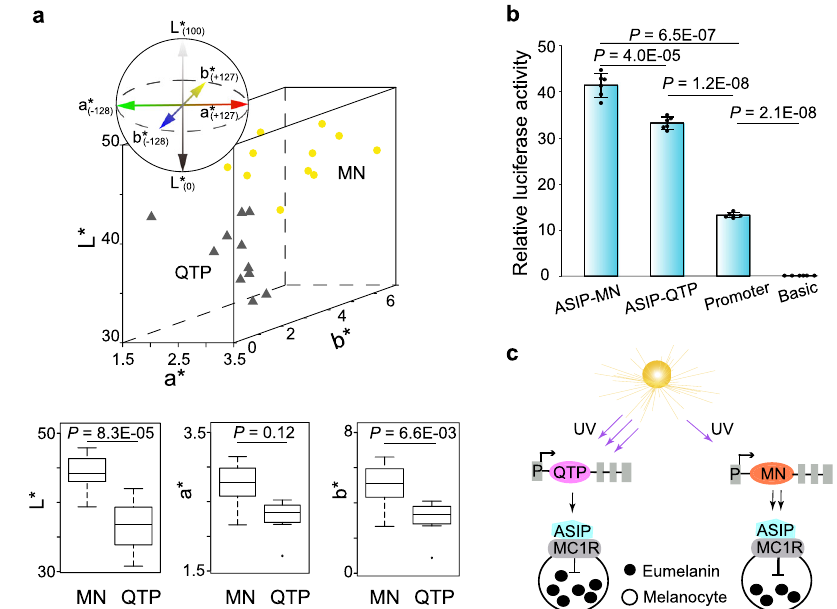
Fig. 5 | Local adaptation and response of QTP sakers to intense UV radiation. a L*a*b* values of plumage color in feathers from MN ( N =11) and QTP sakers ( N = 11).TheyellowdotsandblacktrianglesrepresentMNandQTPsakers,respectively. In the box plots, the center line represents the median, whiskers represent max- imum and minimum values, and box boundaries represent 75th and 25th percen- tiles.Atwo-sided t testwasused. b Relativeluciferaseactivitycomparisonbetween dominant MN- and dominant QTP- CREs in duck embryonic fi broblast cells. The